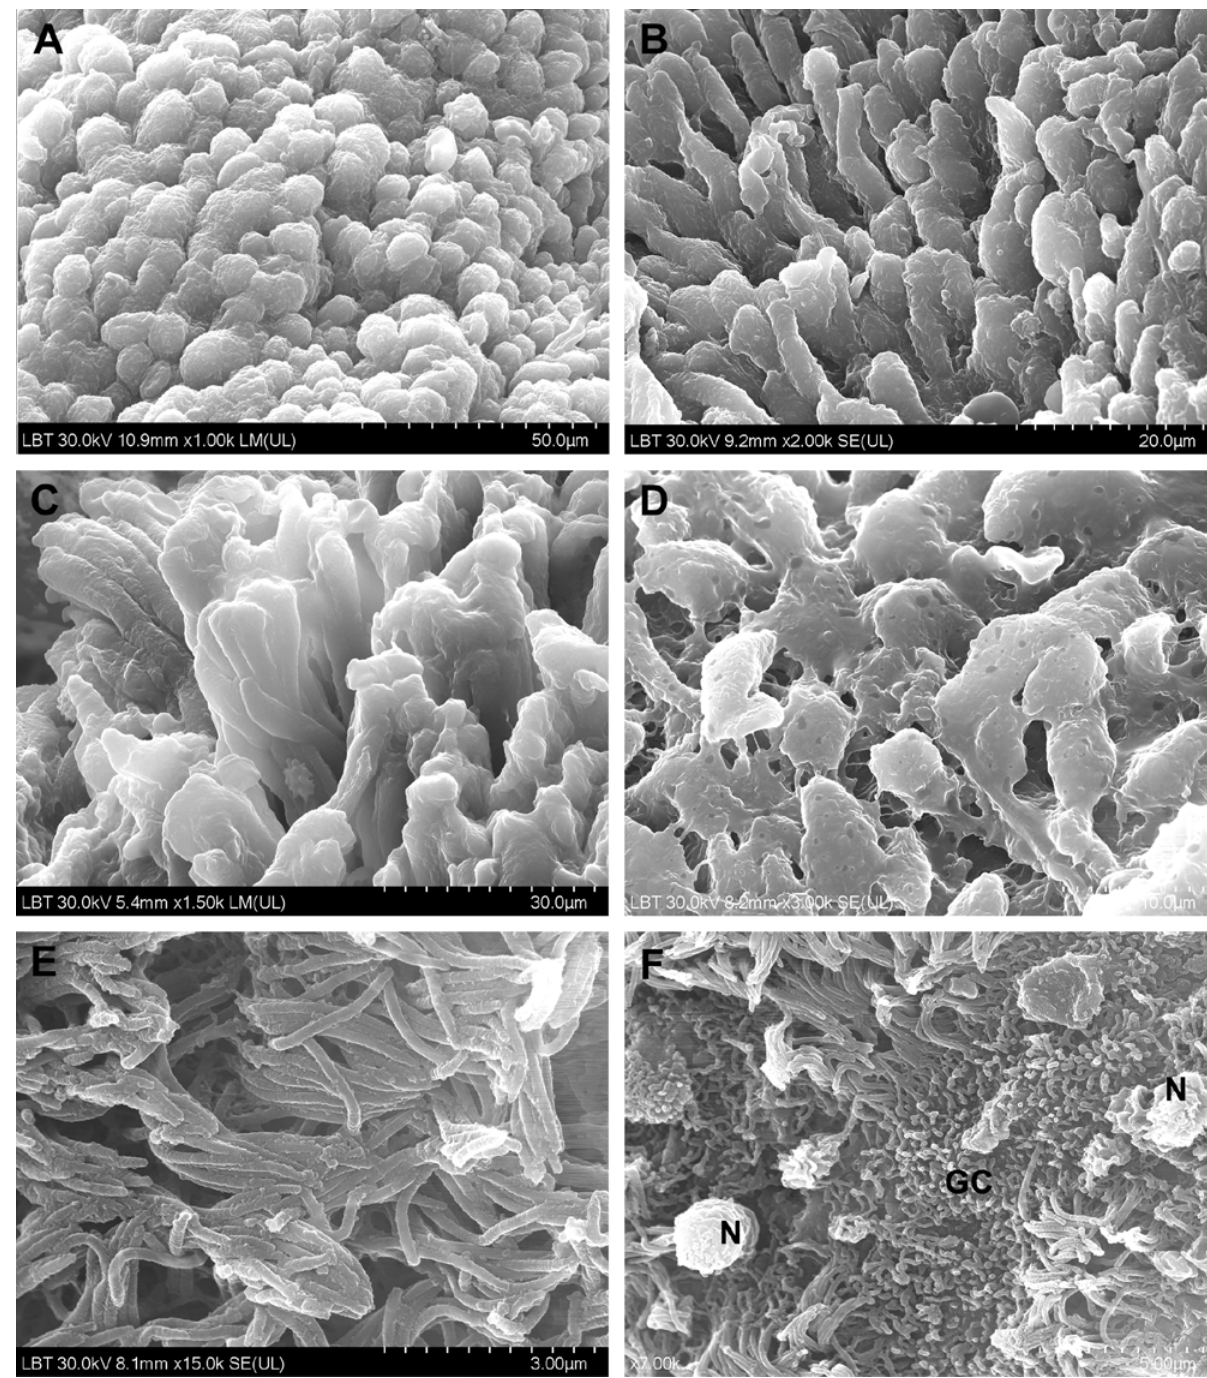
Figure 4. Microvilli and cilia in CRSwNP samples (scanning electron microscopy): ( A , B )—microvilli with normal appearance; ( C )—microvilli partially covered with mucus; ( D )—mucus-embedded microvilli; ( E )—cilia with normal appearance, mainly oriented in the same direction; ( F )—ciliary disorientation, goblet cells area (N—neutrophil, GC—goblet cell).